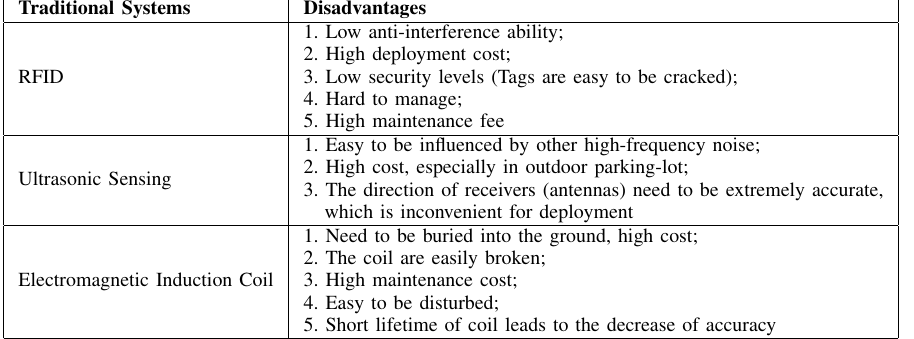
TABLE I D ISADVANTAGES OF T RADITIONAL S MART P ARKING S